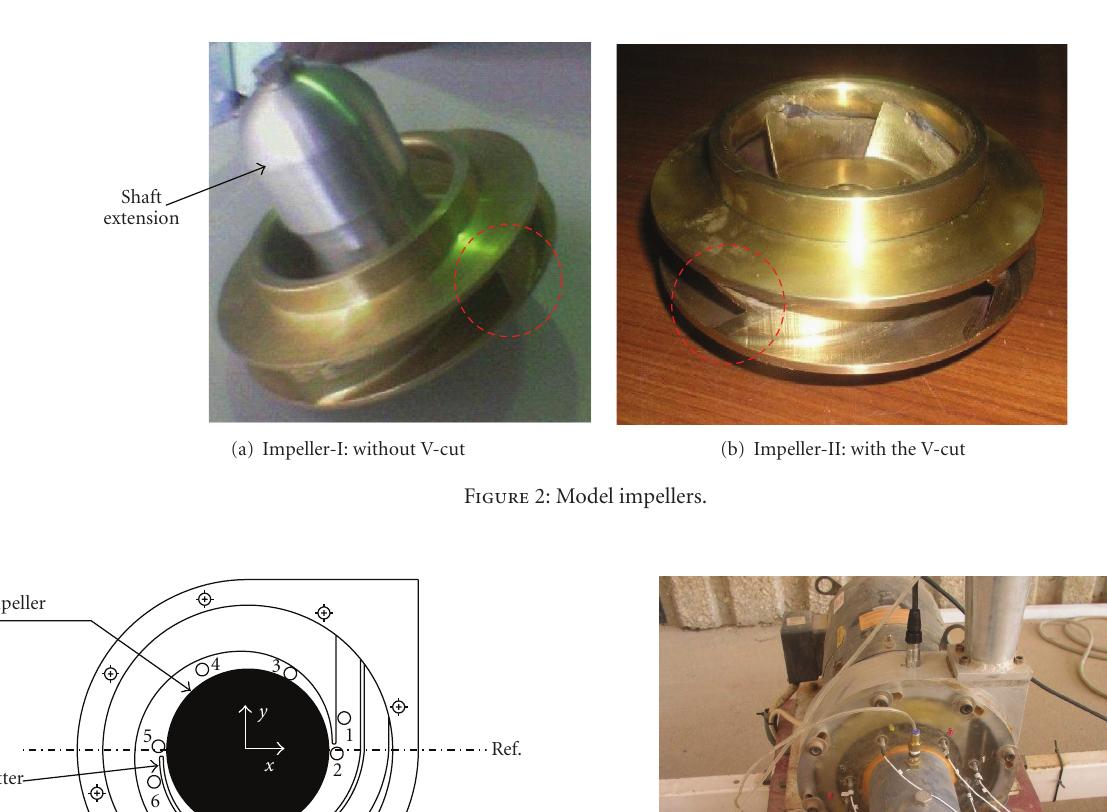
Figure 1: Cartridge of the original boiler feed pump.